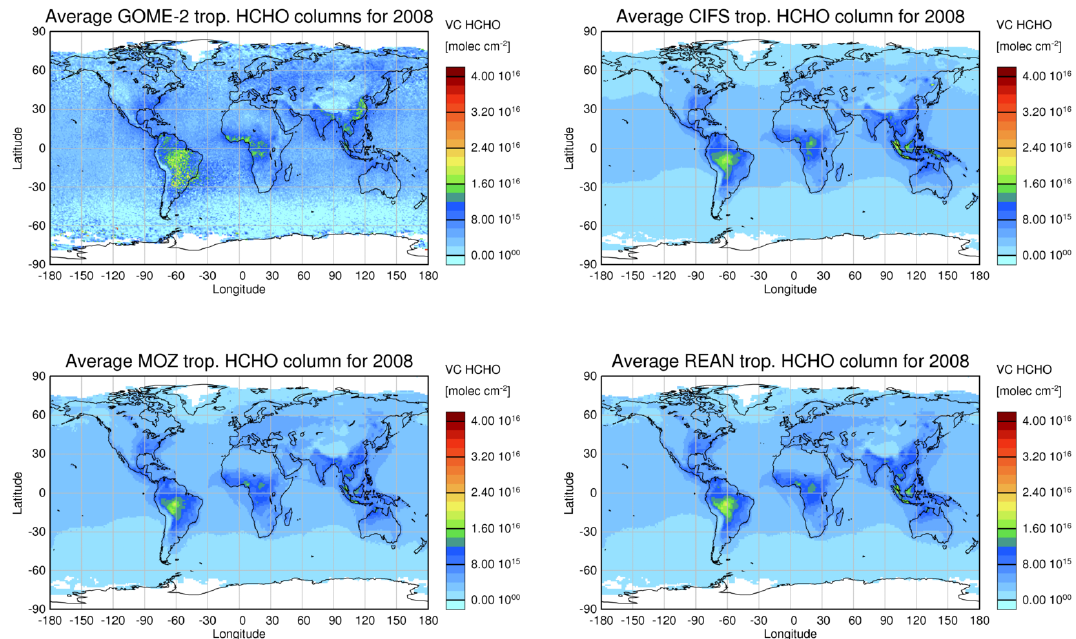
Figure 14. HCHO tropospheric column retrieval (GOME-2) for 2008 (top left) and by C-IFS (top right), REAN (bottom right) and MOZ (bottom left).